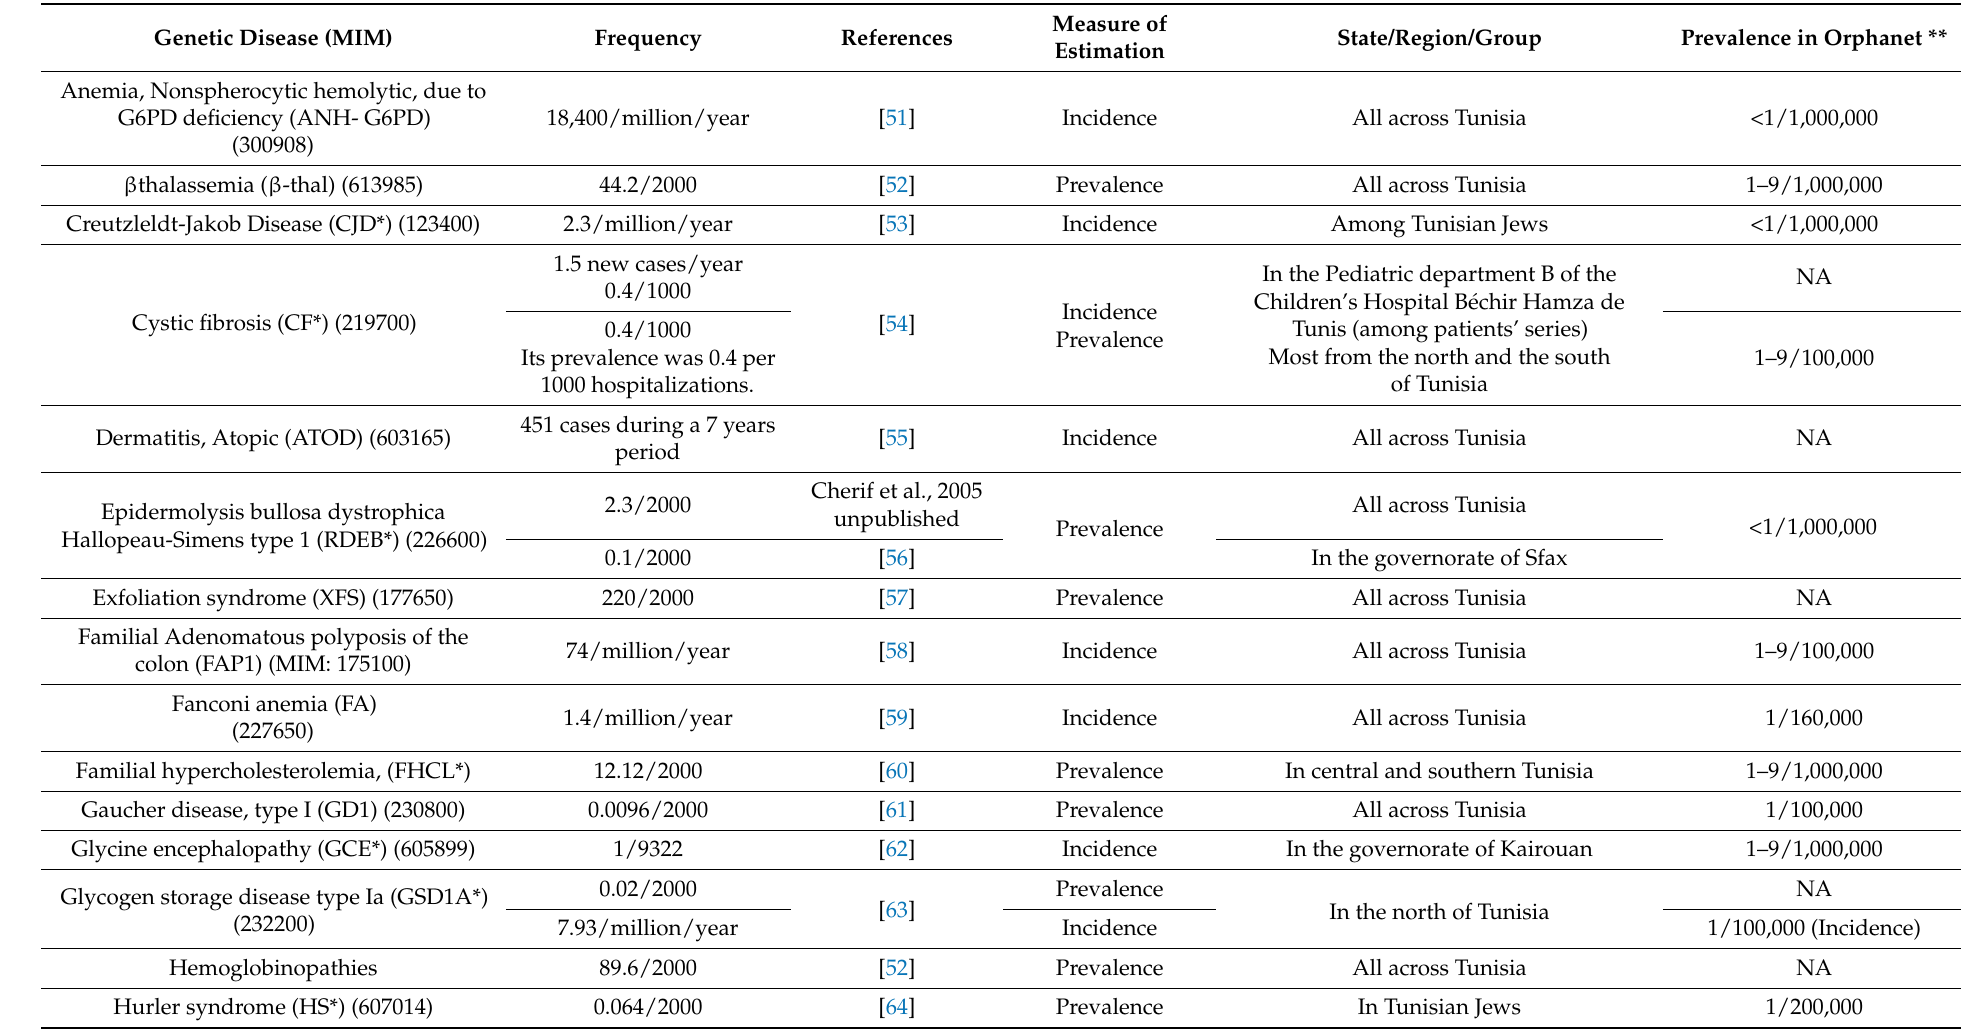
Table 4. Genetic diseases with available epidemiological data among